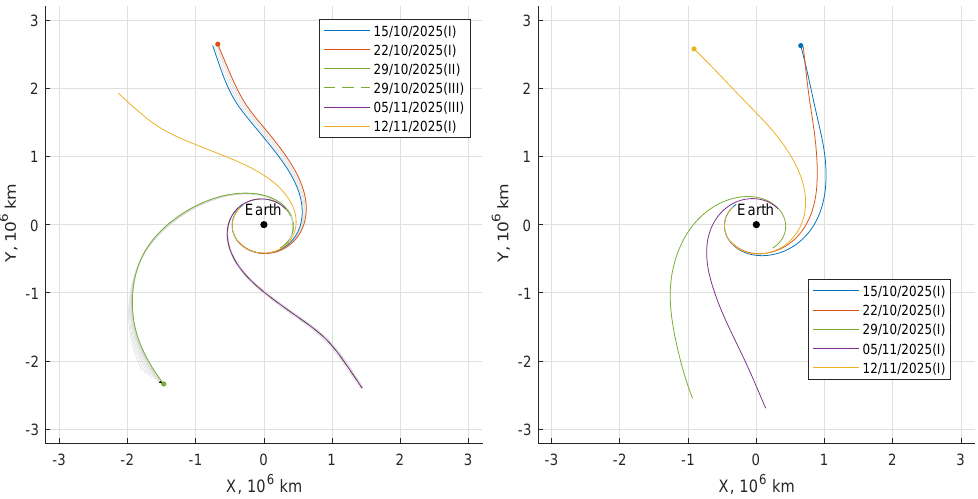
Figure 18. EML2 escape trajectories over a lunar month—fixed C 3 = 0.2 (km/s) 2 ( left ), 0.5 (km/s) 2 ( right ), free t f , EME2000 RF.